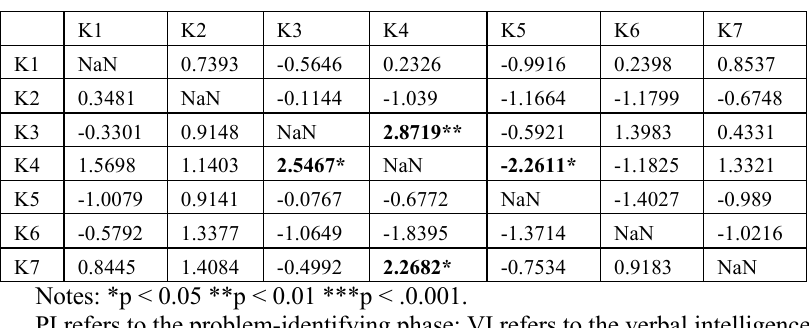
Two-sample t test during PI in the VI